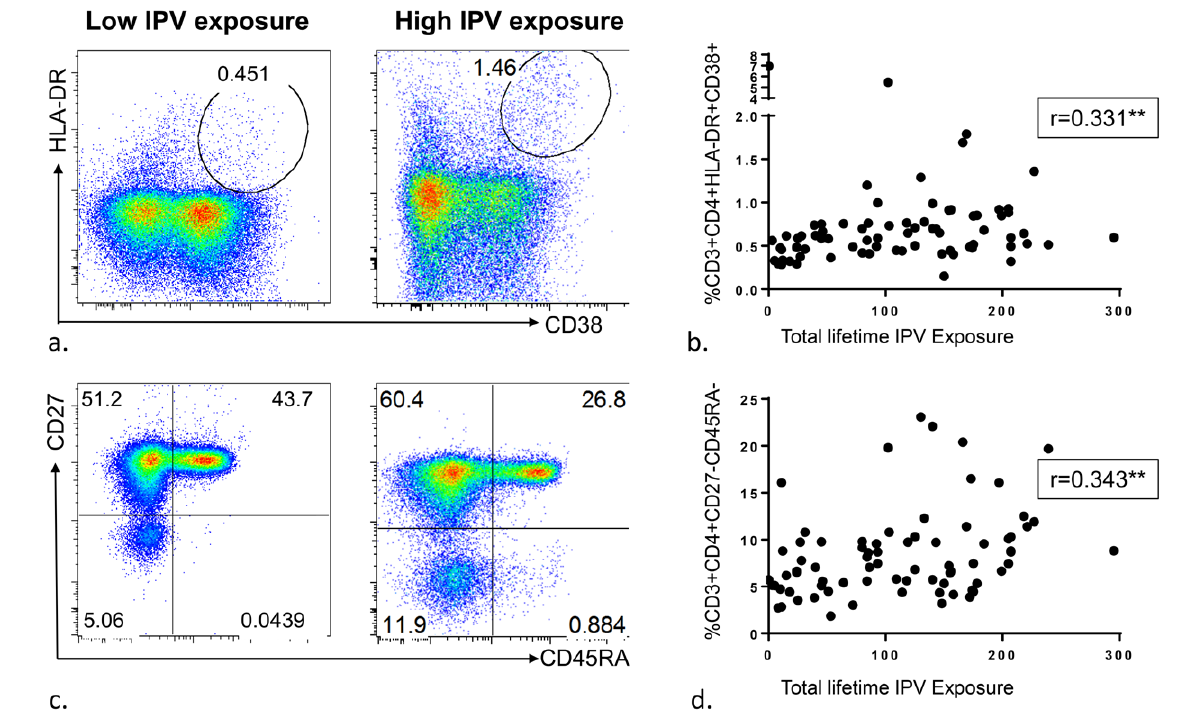
Figure 3. Association between lifetime intimate partner violence (IPV) experience and CD4 + T-cell activation and memory phenotype among HIV high-risk women. (A) Representative flow diagrams demonstrating CD4 + T-cell activation (%HLA-DR + /CD38 + ) in the whole blood of two donors with low versus high reporting of lifetime IPV experience. (B) Summary data from 75 HIV high-risk women demonstrating lifetime IPV reporting is significantly associated with CD4 + T-cell activation (%HLA-DR + / CD38 + ) in whole blood. (C) Representative flow diagrams depicting frequencies of CD4 + T-cell memory phenotypes using CD27 and CD45RA markers in the whole blood of two donors with low versus high re- porting of lifetime IPV experience, and (D) Summary data from 75 HIV high-risk women demonstrating lifetime IPV reporting is significantly associated with an increase in CD4 + effector memory T-cell popula- tion (%CD27 - CD45RA -